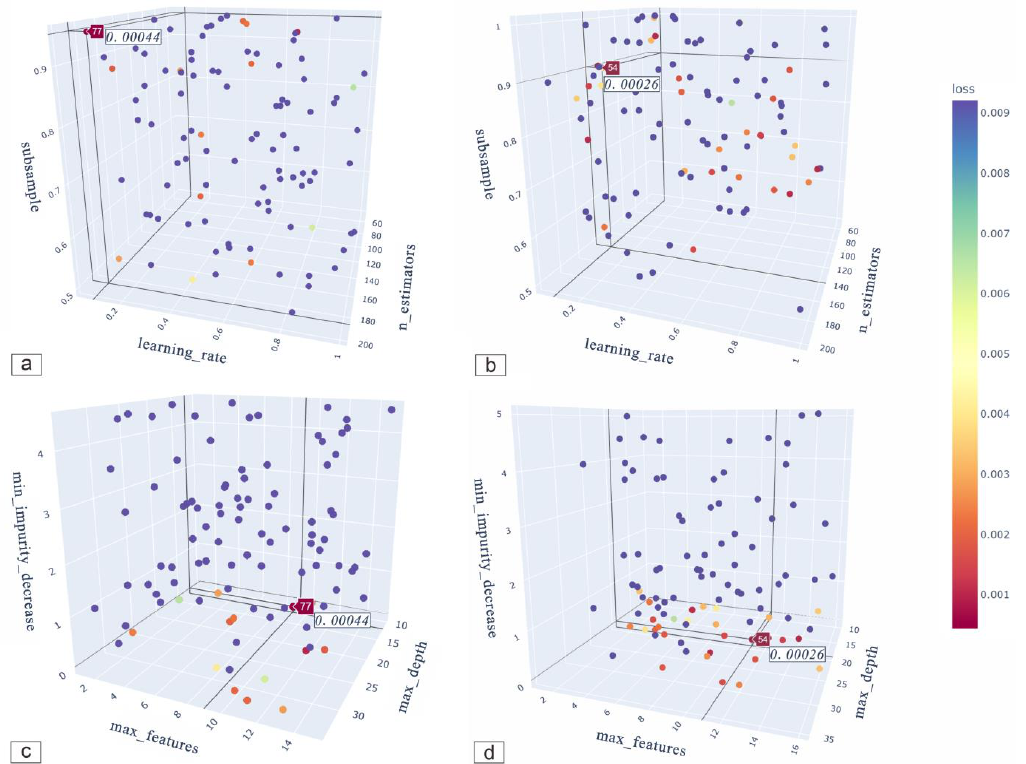
Figure 7. 3D visualization of the random search-GBDT model and TPE-GBDT model results: ( a ) random search-GBDT based on boosting hyperparameters; ( b ) TPE-GBDT based on boosting hy- perparameters; ( c ) random search-GBDT based on weak learner hyperparameters; ( d ) and TPE-GBDT based on weak learner Table 4. The Optimized parameters for the GBDT model.